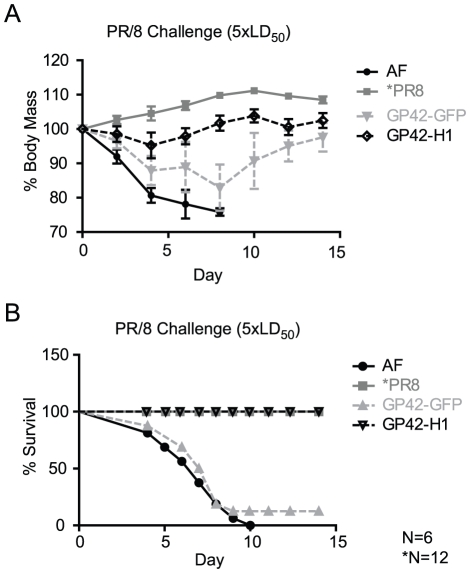
GP42-H1 protects mice from lethal challenge with PR/8 virus.Mice that were administered AF, infected with 1LD50 of PR/8 virus or immunized with 1,000 pfu of GP42-GFP, or 1,000 pfu GP42-H1 (i.n.) were challenged (seven weeks post-immunization) with 5LD50 of PR/8 virus (i.n.) A) Body weight was recorded over 14 days and the percent of the body weight at the time of challenge is shown. B) Animals were monitored for 14 days post challenge and morbidity is recorded. Depicted are the percentages of mice that survived the virus challenge.